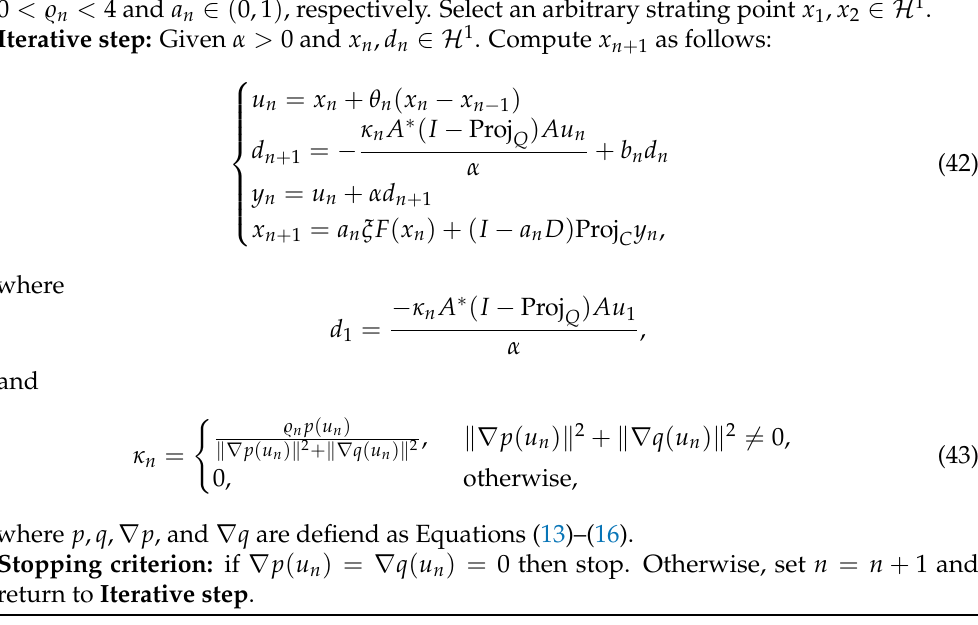
Algorithm 2 An iterative algorithm for solving split feasibility